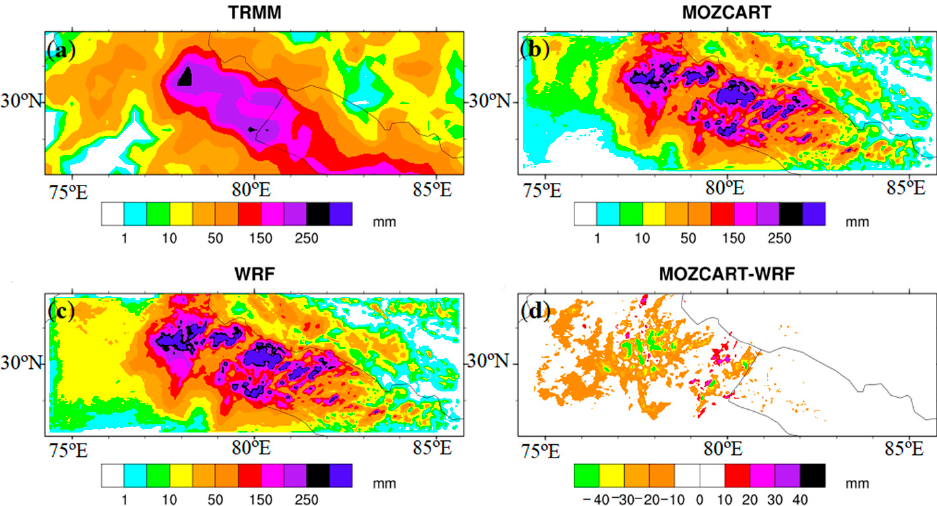
Figure 2. Three days accumulated rain from ( a ) TRMM and the simulation of WRF at a 4 km resolution for ( b ) WC4 and ( c ) WRF4 ( d ) and the difference of rain produced by